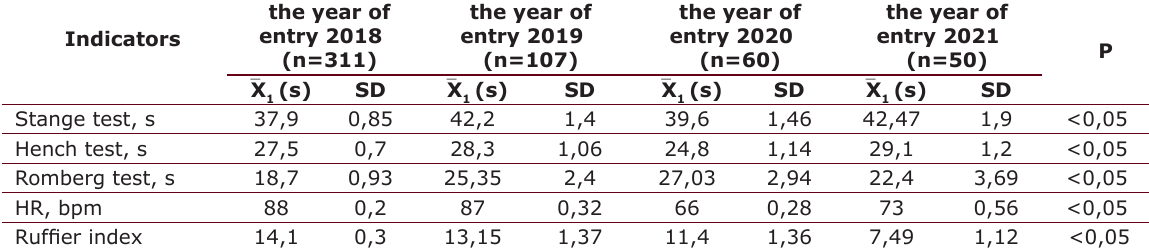
Table 3. Indicators of the functional state of the body of first-year female students in the 2018-2021